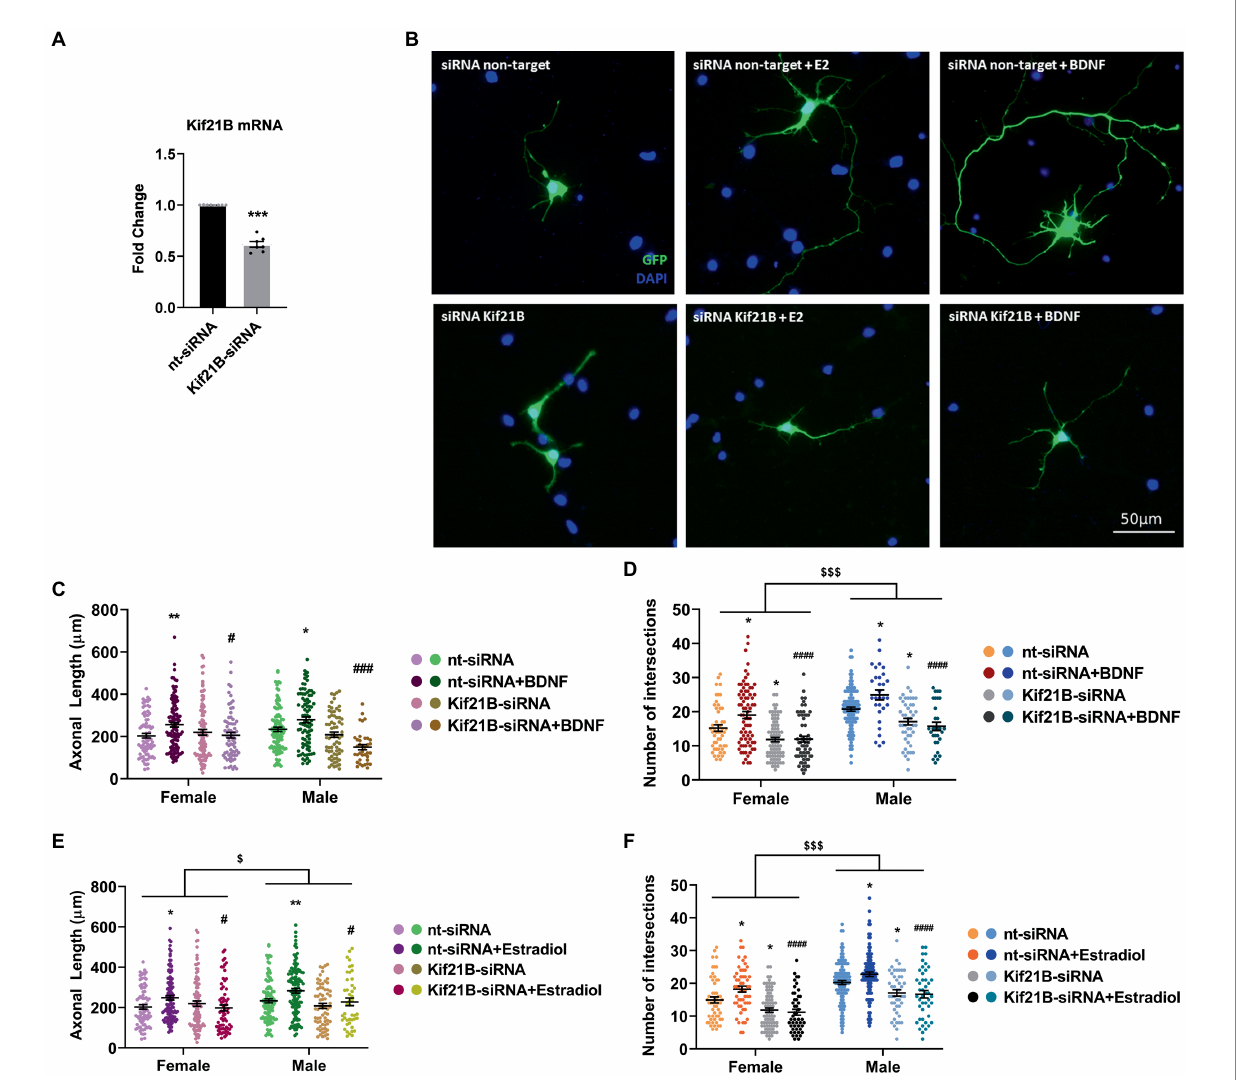
FIGURE 4 Kif21B silencing impairs the neuritogenic effect of Estradiol and BDNF. (A) Downregulation of Kif21B mRNA levels in electroporated cultures with a mix of four specific siRNAs for this gene N = 4. Graph represents the mean ± SEM; Unpaired t -test: *** p < 0.001. (B) Representative example of neurons immunostained for Green Fluorescent Protein (GFP, green) and DAPI (blue). Electroporated neurons with non-target siRNA are shown in the panel above and neurons targeted with Kif21B siRNA are displayed in the panel below. (C–F) Quantitative analysis of axonal length and complexity of the dendritic arbor (number of intersections with the circles in the Sholl analysis) of sex-separated cultures at 3 DIV with non-target or Kif21B siRNA. Neurons quantified (50–100) are at least from four independent experiments. Data represent the mean ± SEM; two-way ANOVA with Tukey’s multiple comparisons: * p < 0.05, ** p < 0.01 vs. nt-siRNA groups; # p < 0.05, ### p < 0.001, #### p < 0.0001 vs. nt-siRNA + Estradiol or BDNF; $ p < 0.05, $$$ p < 0.001 sex